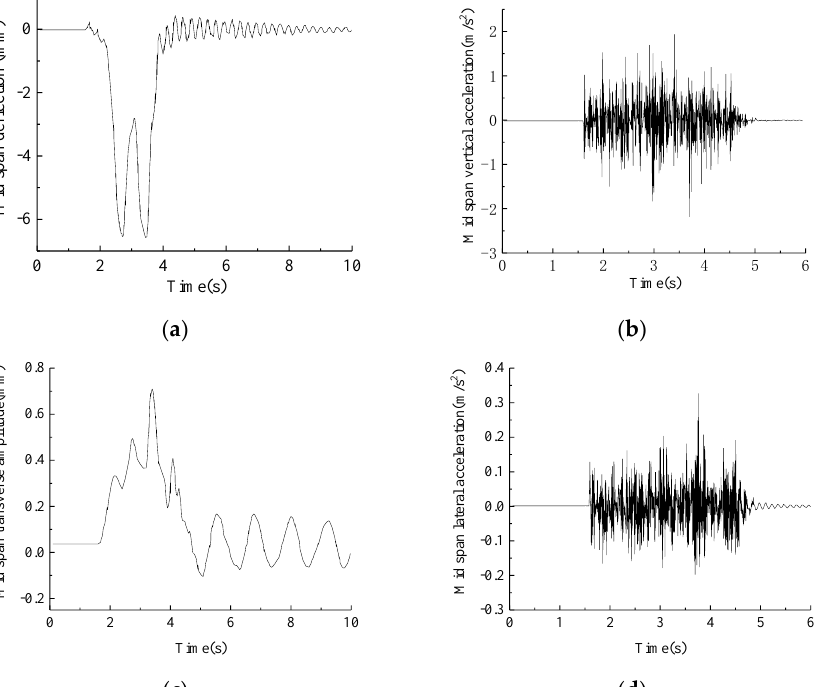
Figure 18. Mid − span vibration response of structure with damping ratio of 0.025: ( a ) Mid − span deflection (mm). ( b ) Mid − span vertical acceleration (m/s 2 ). ( c ) Mid − span transverse amplitude (mm). ( d ) Mid − span lateral acceleration (m/s 2 ).